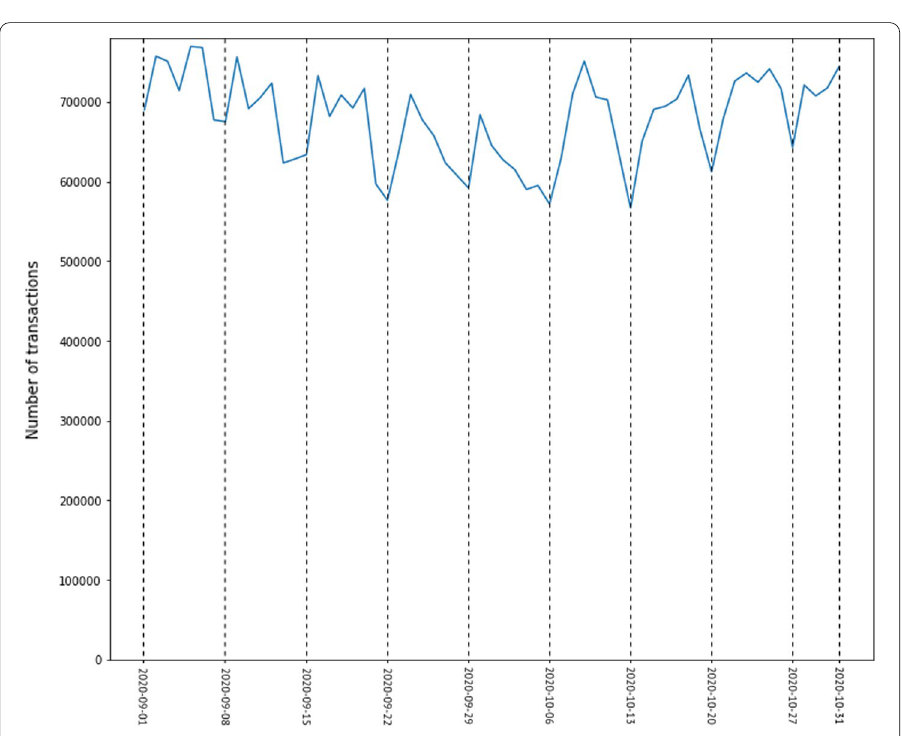
Fig. 1 Number of transactions over